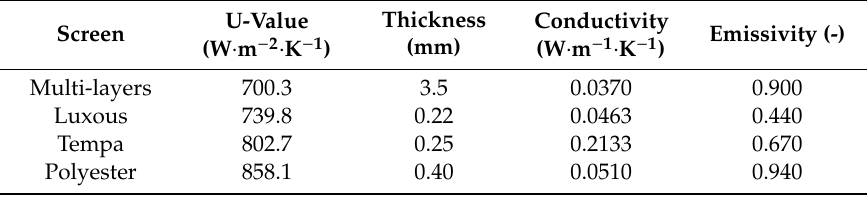
Figure 13. Sensitivity analysis of thermal conductance of thermal screens ( a ) heating demand ( b ) sensitivity coefficient.